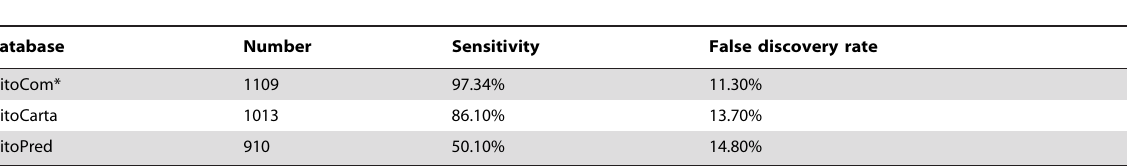
Table 2. Quality comparison of MitoCom with other mitochondrial